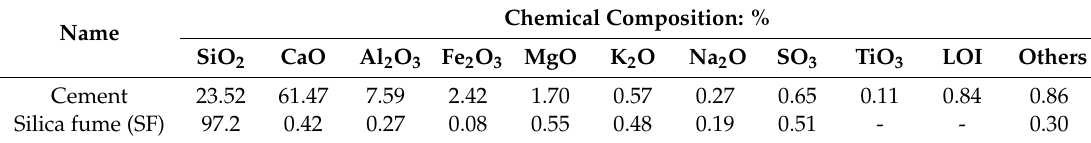
Table 1. Chemical composition of materials.